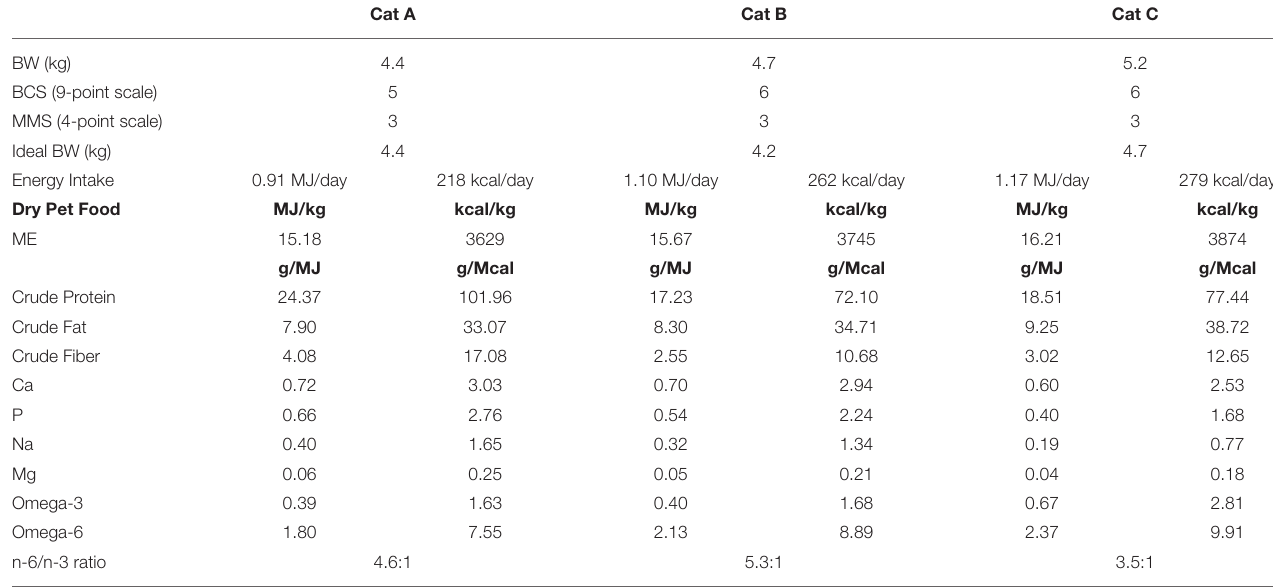
TABLE 2 | Energy intake, body condition assessment, and pet food characteristics at the time of diagnosis. Cat A Cat B